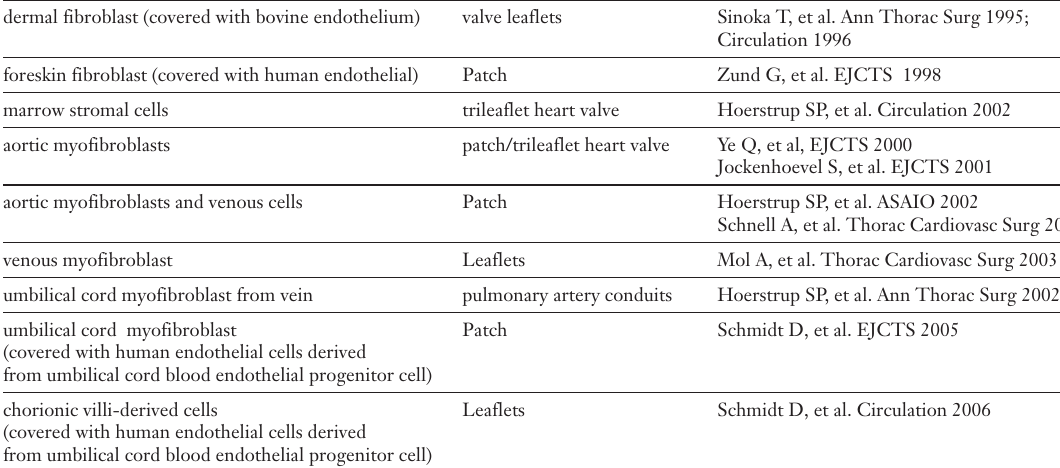
Examples of different cell sources for heart valve tissue